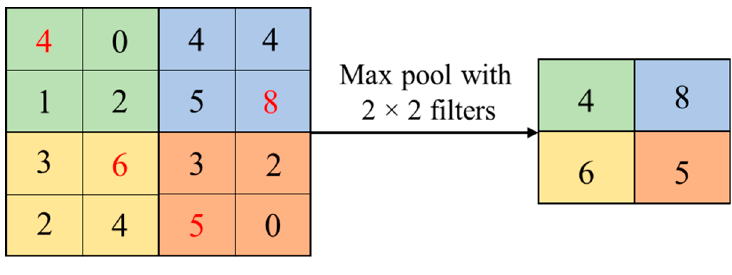
Figure 8. Max pooling layer.